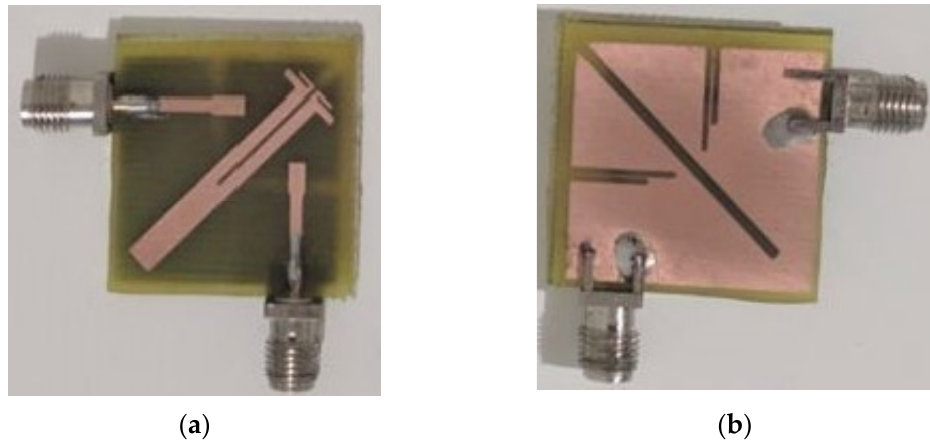
Figure 12. Dual-band MIMO antenna prototype: ( a ) top view and ( b ) bottom view.